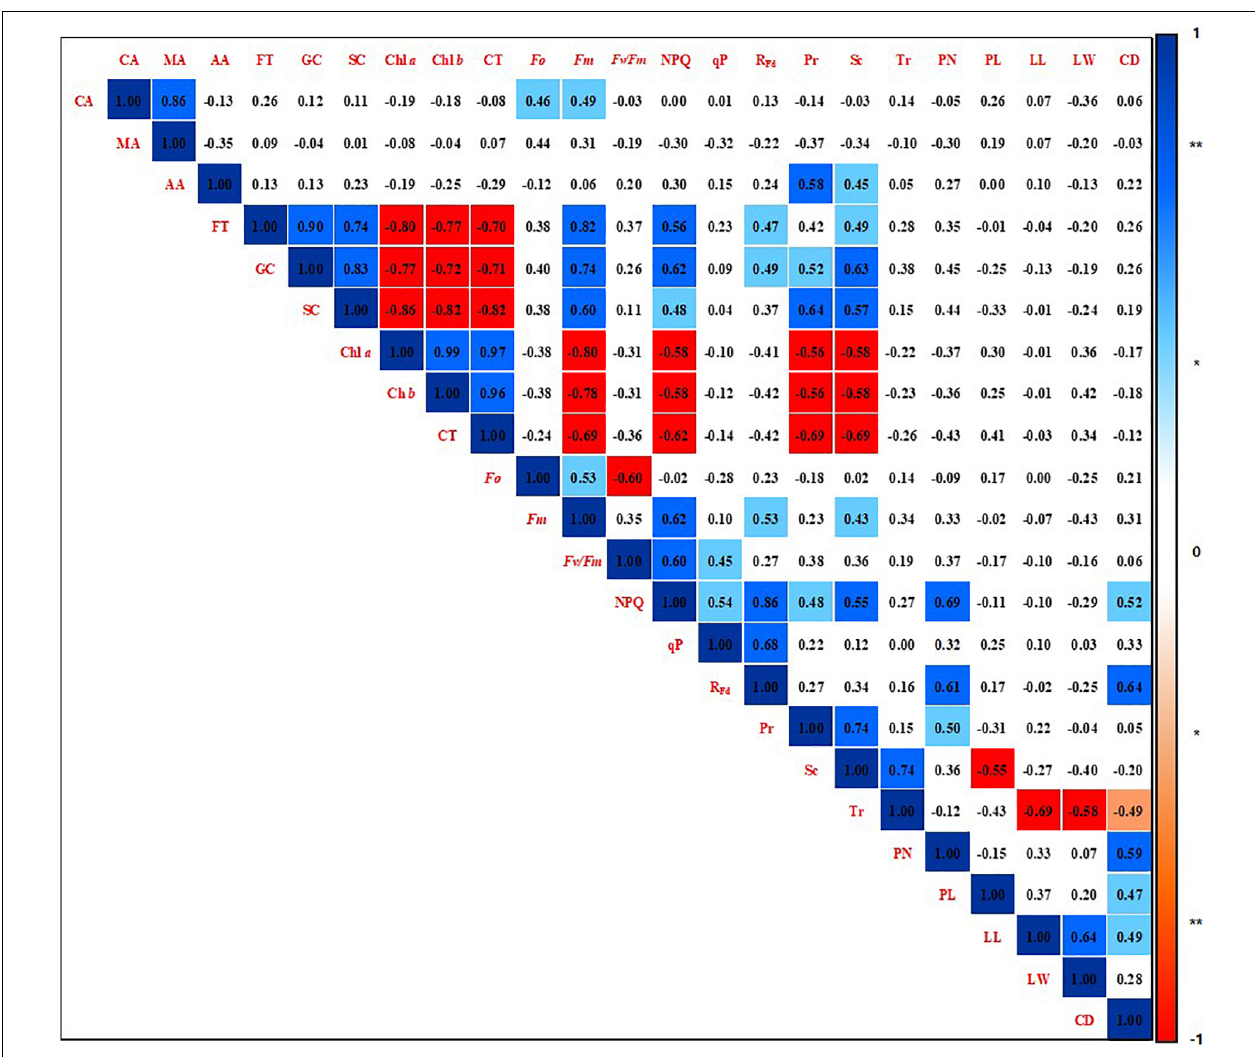
FIGURE 6 | Correlation coefficients among phenotypic parameters of strawberry ( Fragaria × ananassa ) plants grown under various light intensity conditions in a smart greenhouse. Significant differences are shown at the 5 and 1% levels ( n = 9), respectively, using Pearson correlation coefficients. **Dark blue box: positive correlation of 99%, **red box: negative correlation of 99%, *light blue box: positive correlation of 95%, *pink box: negative correlation of 95%, white box: non-significant correlation. CA, citric acid; MA, malic acid; AA, acetic acid; FT, fructose; GC, glucose; SC, sucrose; Chl a , chlorophyll a ; Chl b , chlorophyll b ; CT, carotenoids; F o , minimum fluorescence when all photosystem II (PSII) reaction centers (RCs) are open; F m , maximal fluorescence when all PSII RCs are closed; F v / F m , maximum quantum yield of PSII photochemistry; NPQ, non-photochemical quenching of maximal fluorescence; qP, photochemical quenching of variable fluorescence; R Fd , fluorescence decline ratio in light; Pr, photosynthetic rate; Tr, transpiration rate; Sc, stomatal conductance; PN, petiole number; PL, petiole length; LL, leaflet length; LW, leaflet width; CD, crown